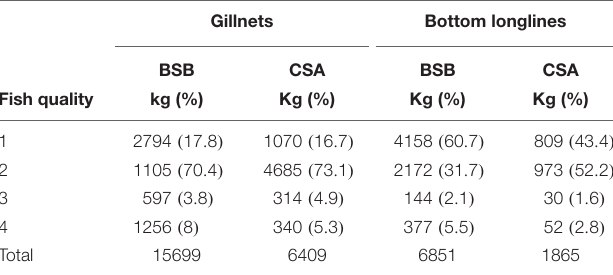
TABLE 4 | Summary of quality of commercial fish catch in relation to fishing gear.